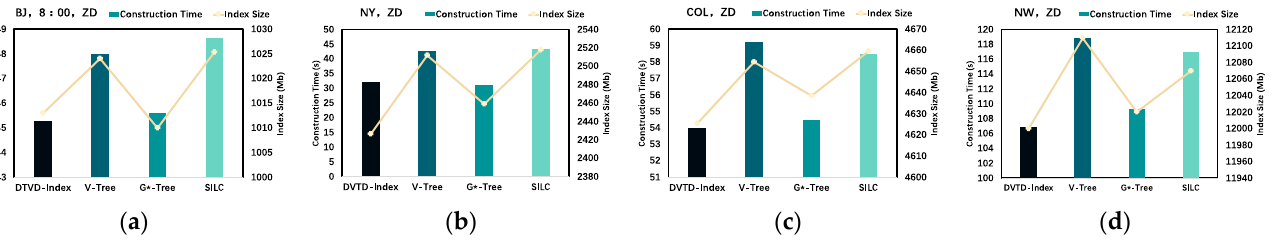
Figure 10. Comparison of construction time and space costs between baseline algorithms and DVTG-Index. ( a ) Construction time and space costs on BJ; ( b ) Construction time and space costs on NY; ( c ) Construction time and space costs on COL; ( d ) Construction time and space costs on NW.